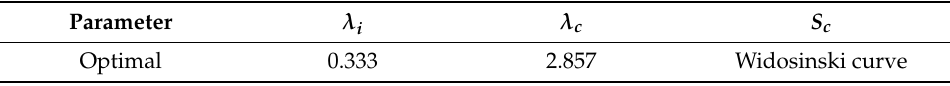
Table 8. Optimal parameters of the nozzle.